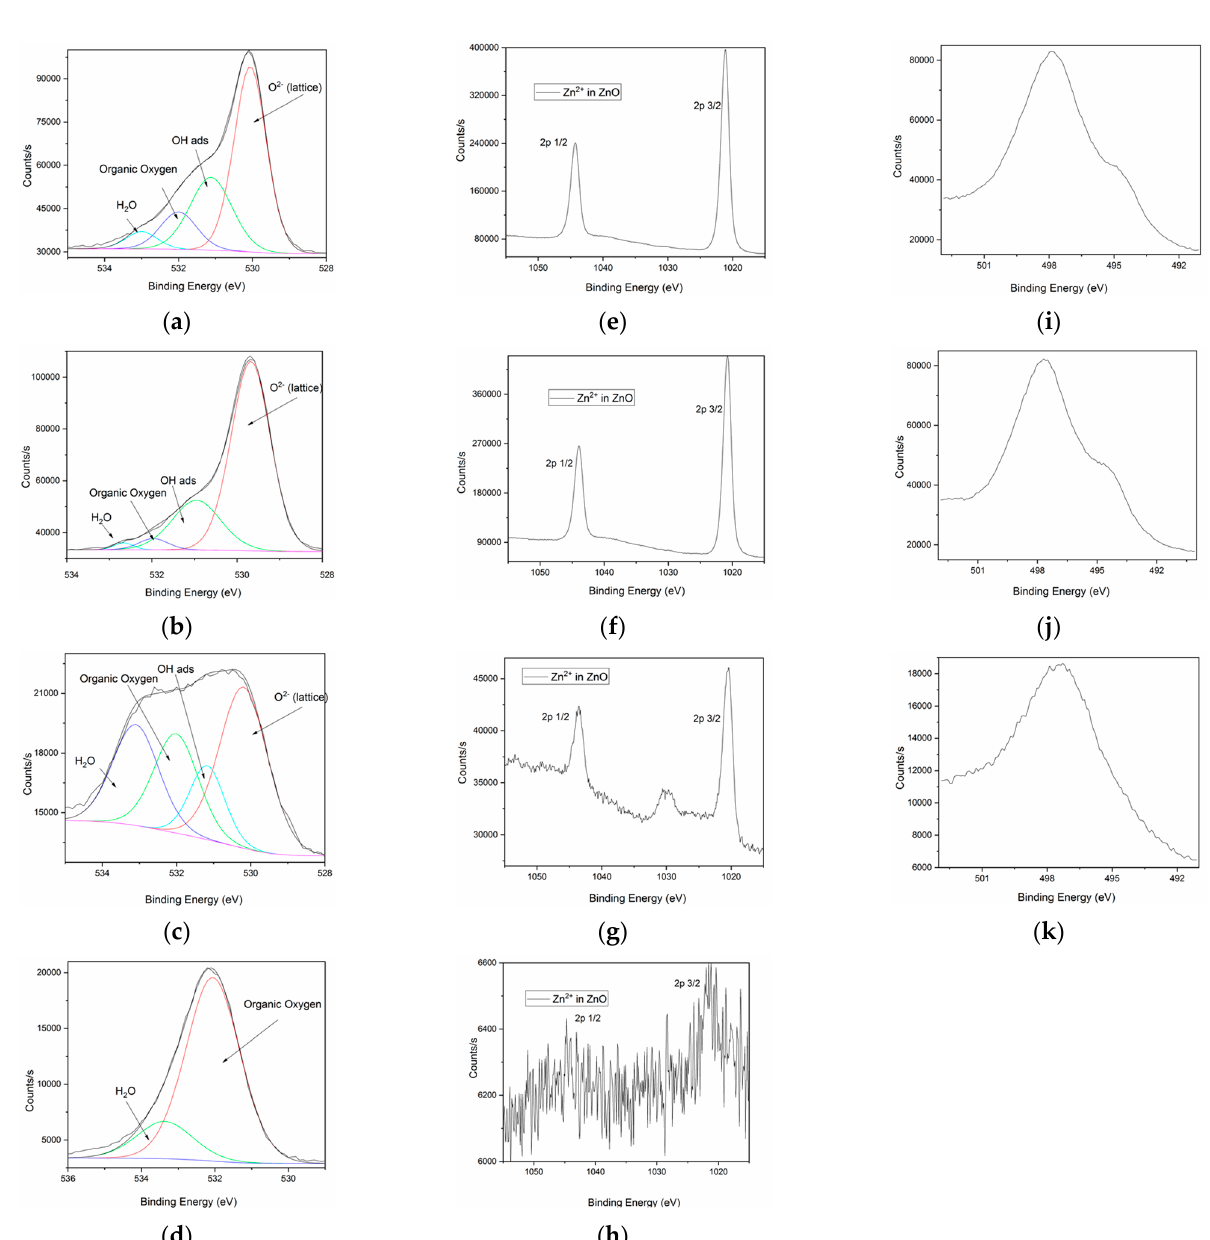
Figure 5. XPS high-resolution spectra in O1s region for ZnO samples obtained in various conditions (details in Table 1): ( a ) ZnO_1; ( b ) ZnO_2; ( c ) ZnO_3; ( d ) ZnO_4. XPS high-resolution spectra in Zn2p region for ZnO samples obtained in various conditions: ( e ) ZnO_1; ( f ) ZnO_2; ( g ) ZnO_3; ( h ) ZnO_4. XPS high-resolution spectra in ZnLM2 region for ZnO samples obtained in various conditions: ( i ) ZnO_1; ( j ) ZnO_2; ( k ) ZnO_3.